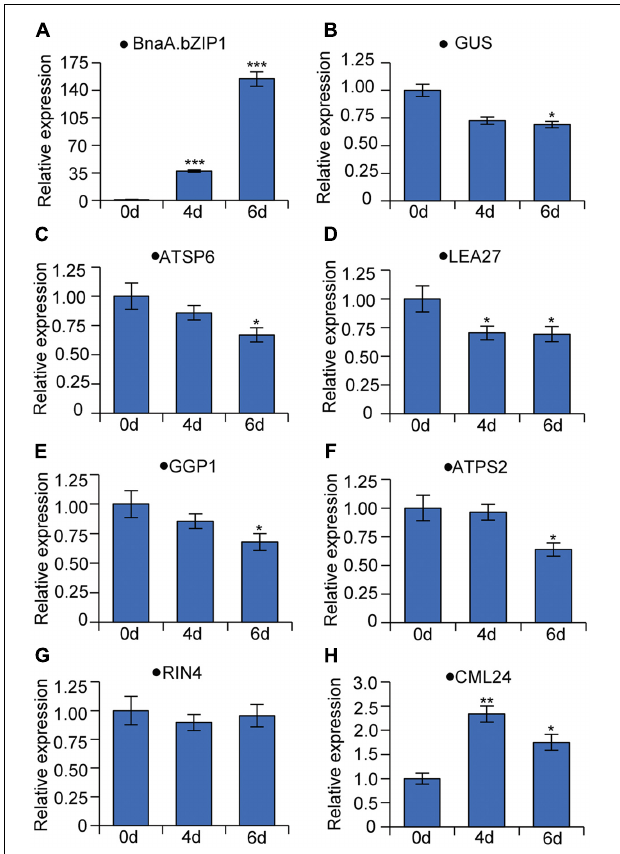
FIGURE 6 | qRT-PCR analyses of genes bound and repressed by AtbZIP1 in DEX-induced BnaA.bZIP1/p158 plants. The data were calculated according to the 2 − (cid:49)(cid:49) C t method and the mRNA levels of genes on 0 day were set to 1. Bars show means ± SD ( n = 3). The RNA samples from buds were tested on 0, 4, and 6 days after treatment with DEX. (A–H) Relative mRNA levels of BnaA.bZIP1 , GUS ( Escherichia coli beta-glucuronidase gene), ATSP6 (At1g19500), LEA27 (LATE EMBRYOGENESIS ABUNDANT 27, At2g46140), GGP1 (GAMMA-GLUTAMYL PEPTIDASE 1, At4g30530), ATPS2 (PHOSPHATE STARVATION-INDUCED GENE 2, At1g73010), RIN4 (RPM1-interacting protein 4 family protein, At2g17660), and CML24 (CALMODULIN-LIKE 24,